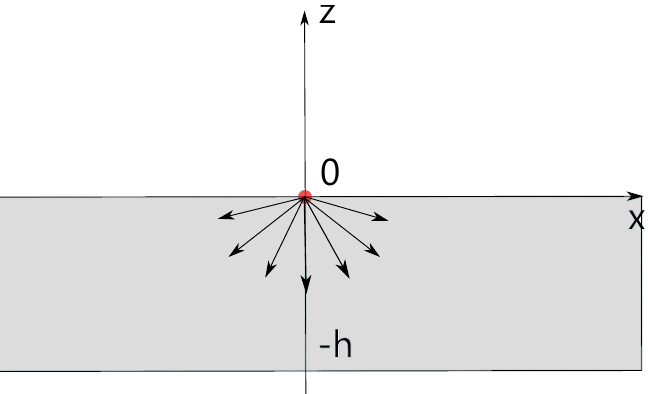
Figure 2. Geometry of the